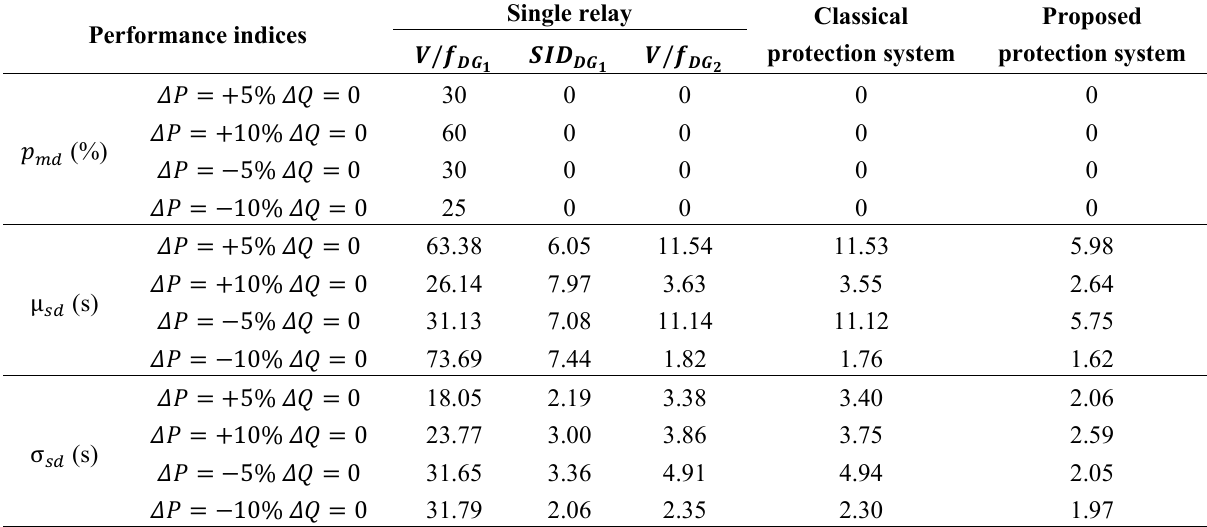
Table 11. Comparison between the classical and the proposed protection systems in the Case A. Single relay Classical Performance indices protection system